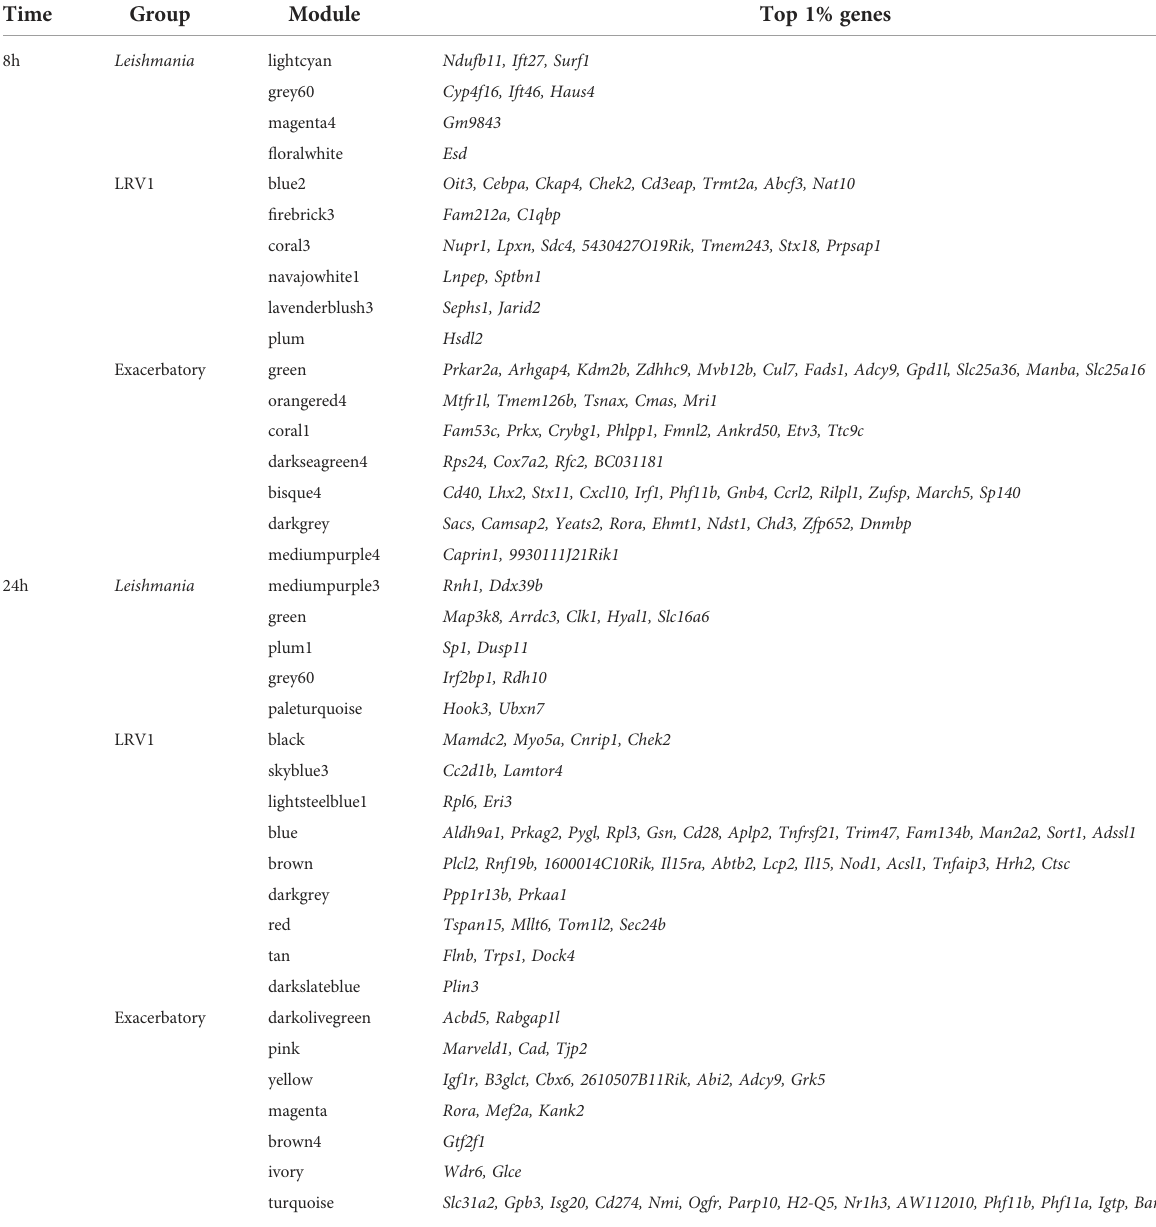
downregulated genes was achieved by the 24h_grey60 and 24h_plum1 showing both the downregulation of genes associated with Leishmania but being either upregulated or non- modulated by poly I:C. As mentioned previously, the 24h_grey60